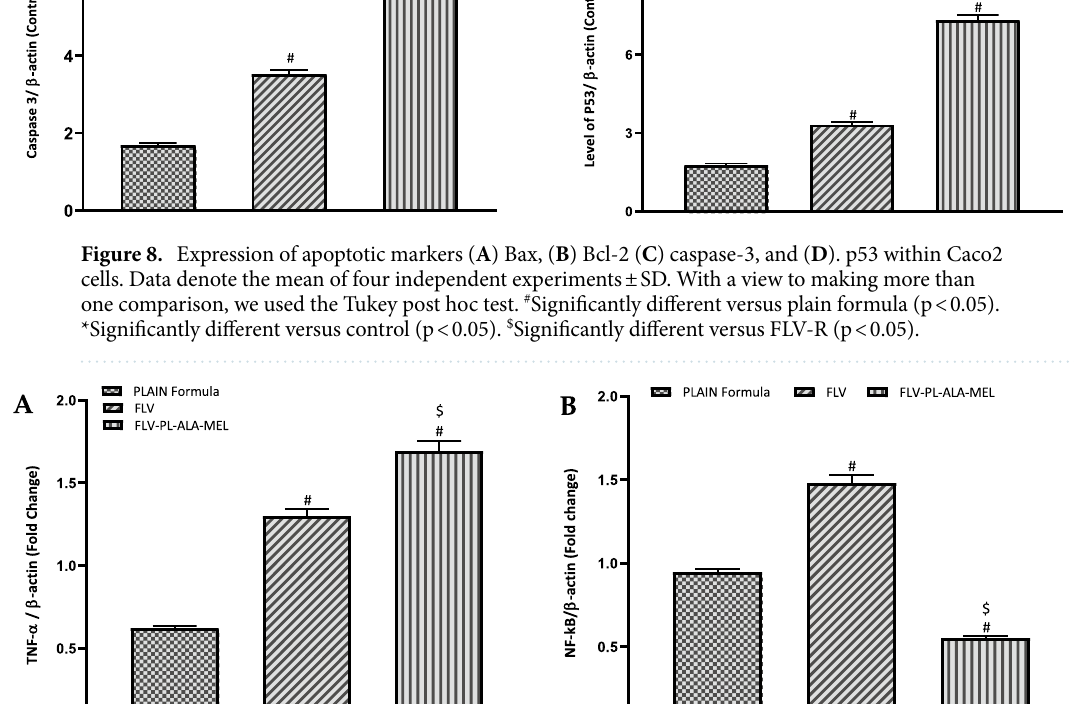
Figure 9. Modulation of treatments using the plain formula, FLV-raw and FLV-PL-ALA-MEL over Expression level of inflammatory markers ( A ) TNF-α and ( B ) NF-kB. Data denote the mean of four independent experiments ± SD. To make several comparisons, we used the Tukey post hoc test. *Significantly different versus control (p < 0.05). # Significantly different versus plain formula (p < 0.05). $ Significantly different versus FLV raw (P <